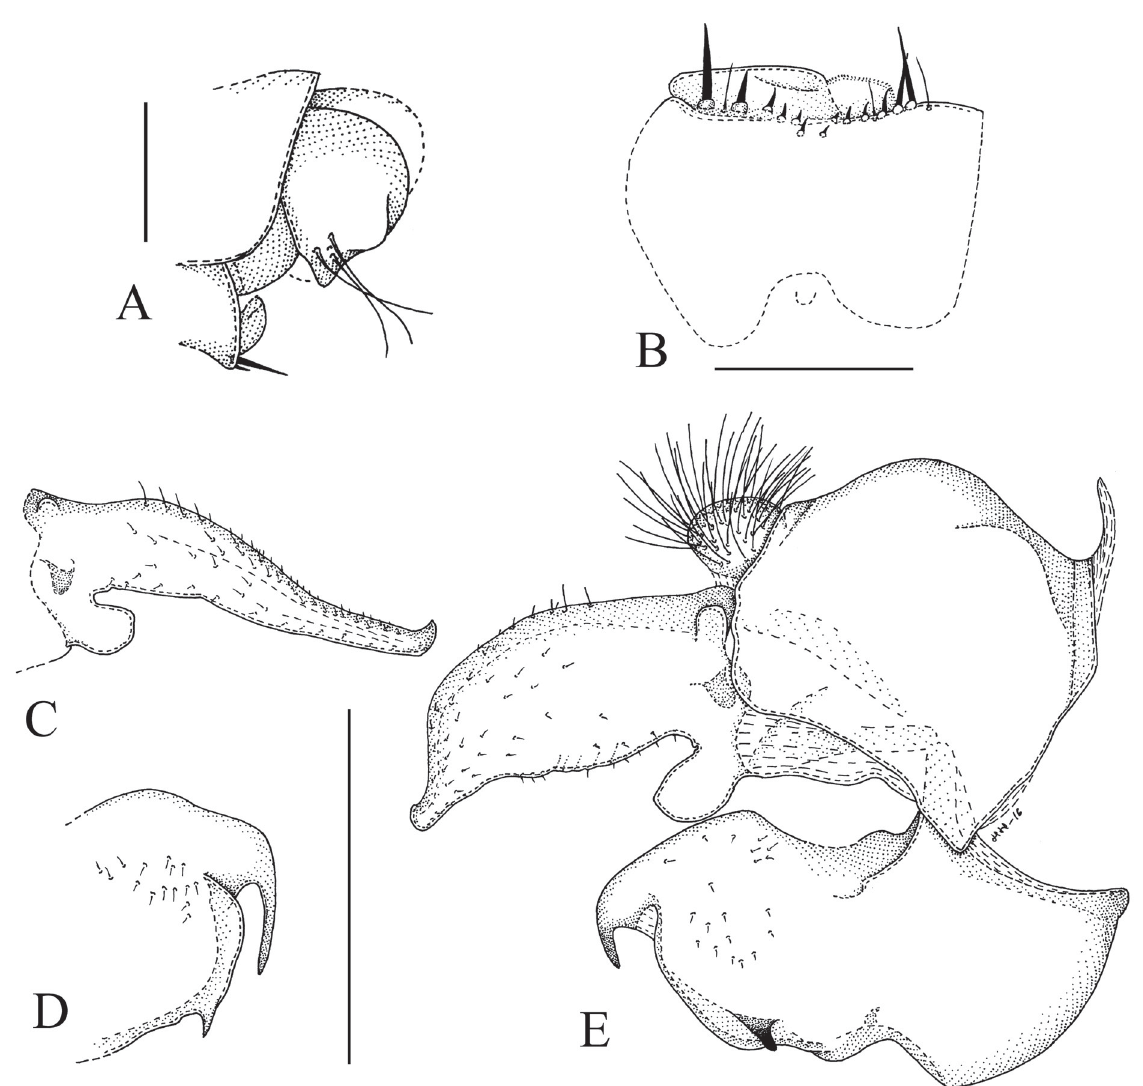
Fig. 20. Sphegina (Asiosphegina) clavigera sp. nov., holotyp e, ♂ . A . Posterior part of abdomen, left side, lateral view. B . Sternum IV, ventral view. C . Left surstylus, lateral view. D . Left superior lobe, lateral view. E . Genitalia, right side, lateral view. Scale bars = 0.5